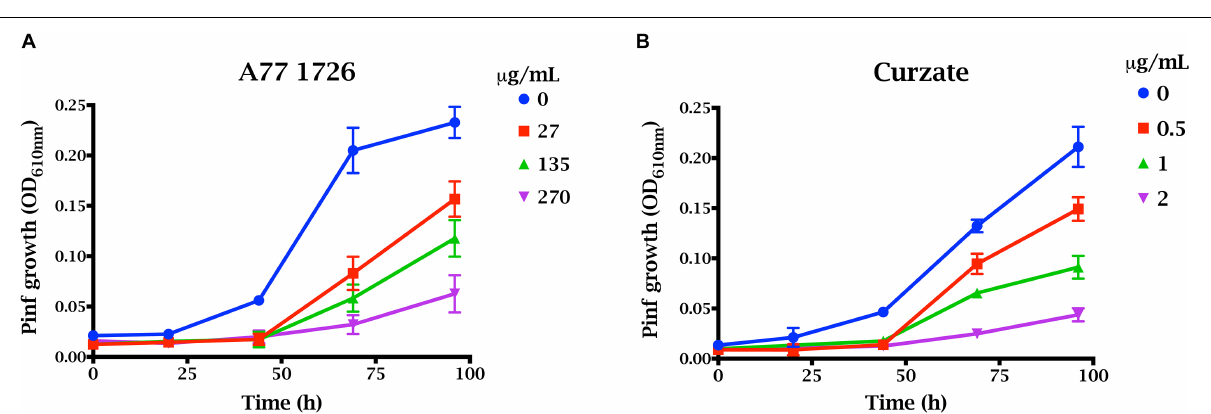
a hydrophobic tunnel where ubiquinone is thought to bind (Reis et al.,